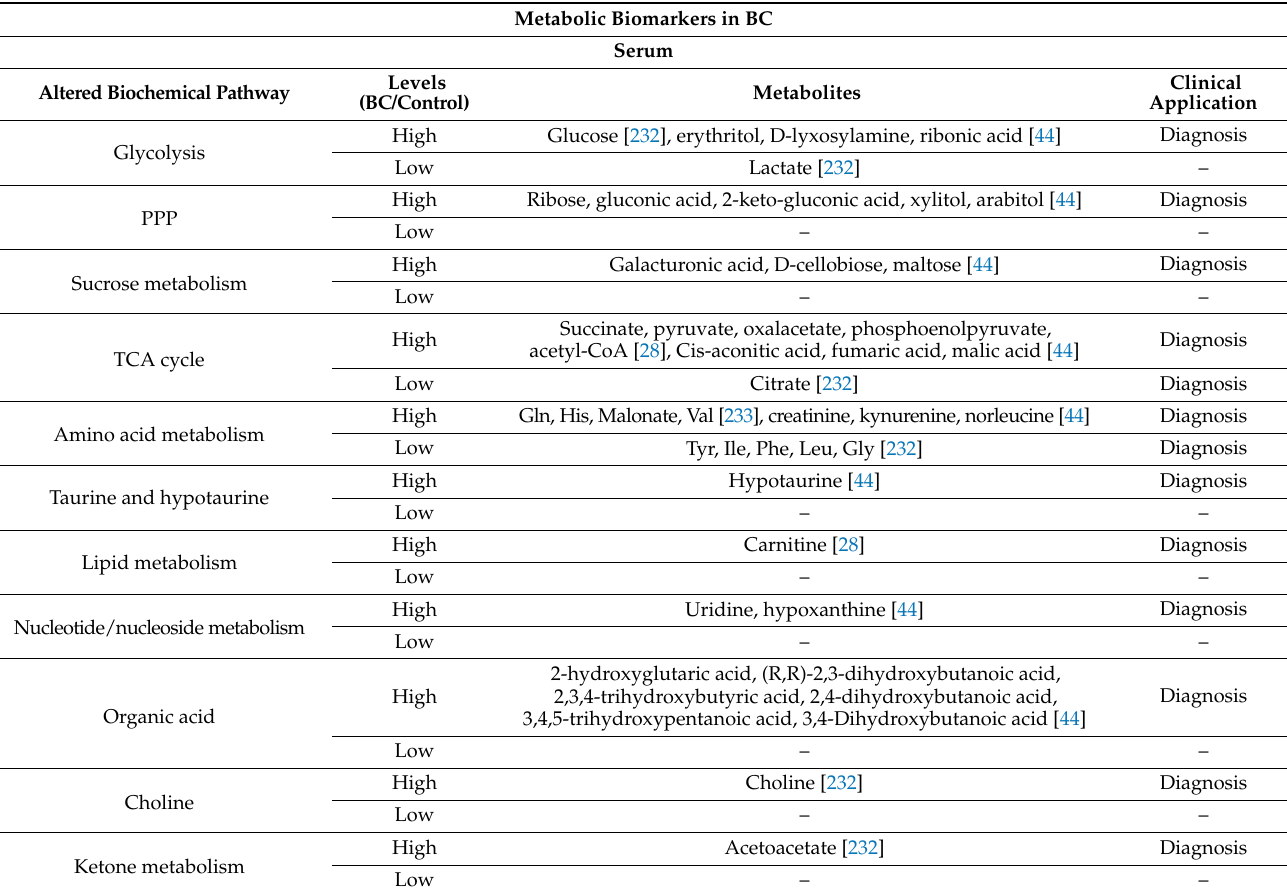
Table 2. Putative identified metabolites and associated pathways in BC serum